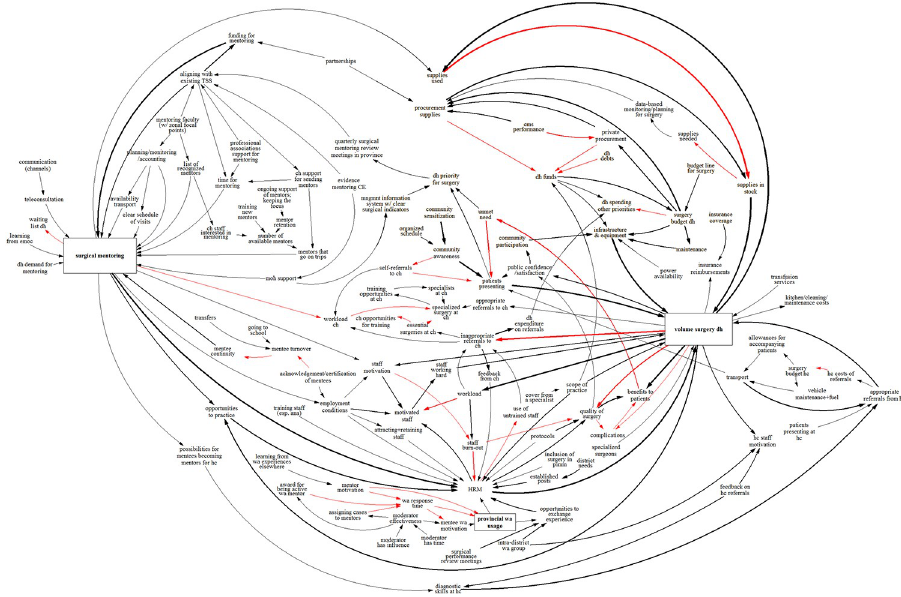
Fig 6. Integrated CLD with all matched factors. Black arrows denote positive links, while red arrows denote negative links. The thickness of arrows indicates how often links were mentioned across workshops. The boxes indicate the core factors. As there are many feedback loops the notation for them has been omitted for clarity.